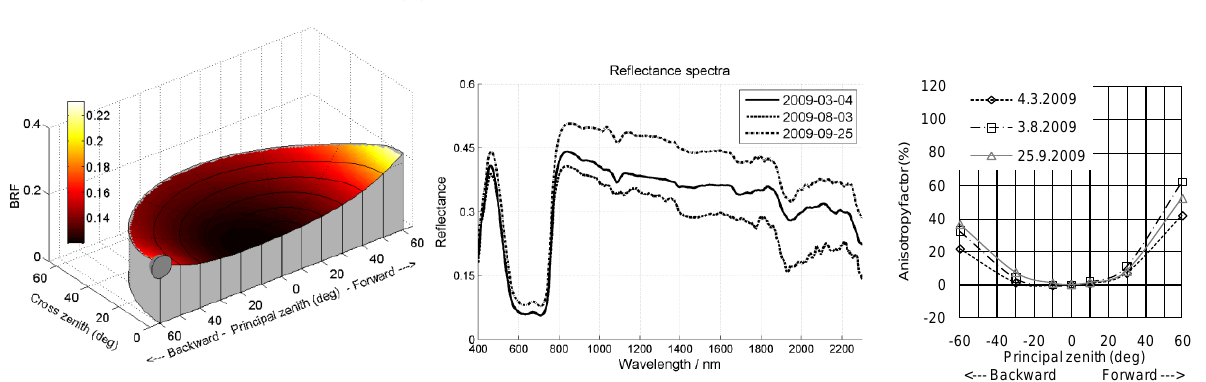
Figure 7. Reflectance characterization of concrete targets (a) blue PT_B, (b) green PT_G, (c) red PT_R and (d) yellow PT_Y, as in Figure